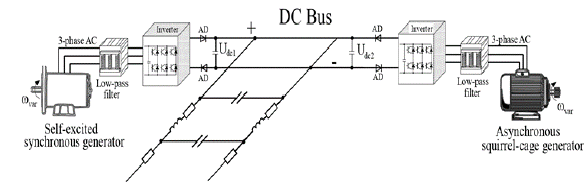
Fig. 1. An example of ship DC grid system with intermediate circuits of inverters connected by auctioneering diodes (AD) in Master/Slave topology.